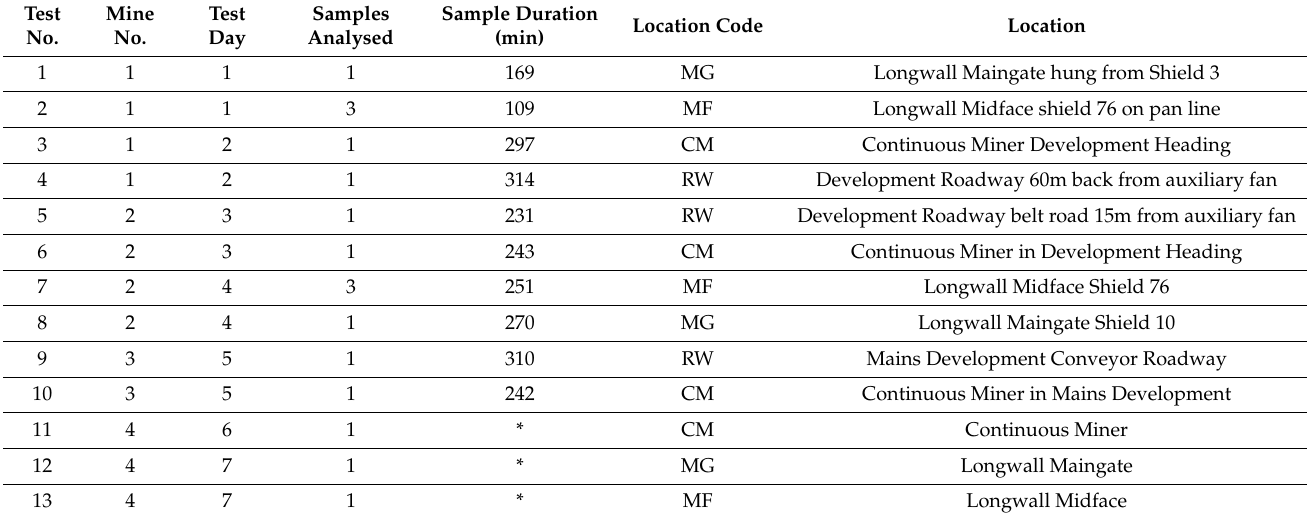
Table 1. Sampling set